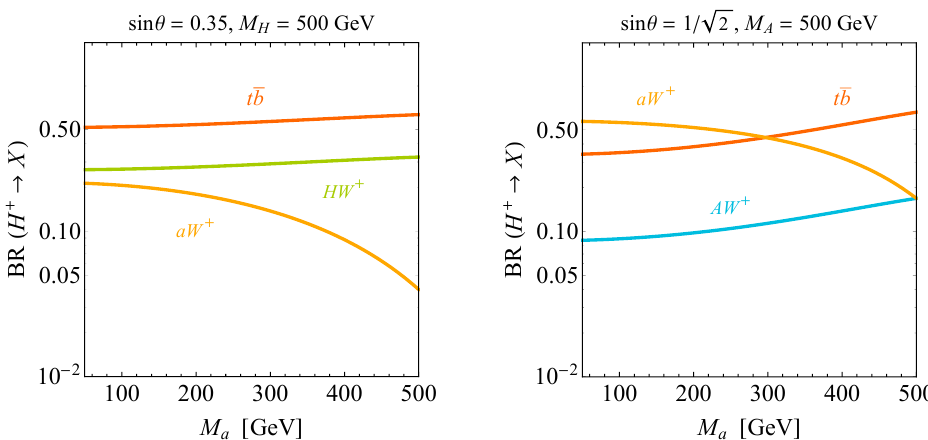
Figure 6 . Branching ratios of the charged scalar H + as a function of M a for two di(cid:11)erent sets of input parameters as indicated in the headline of the plots. In the left (right) panel in addition tan (cid:12) = 1 and M A = M H (cid:6) = 750 GeV ( M H = M H (cid:6) = 750 GeV) is